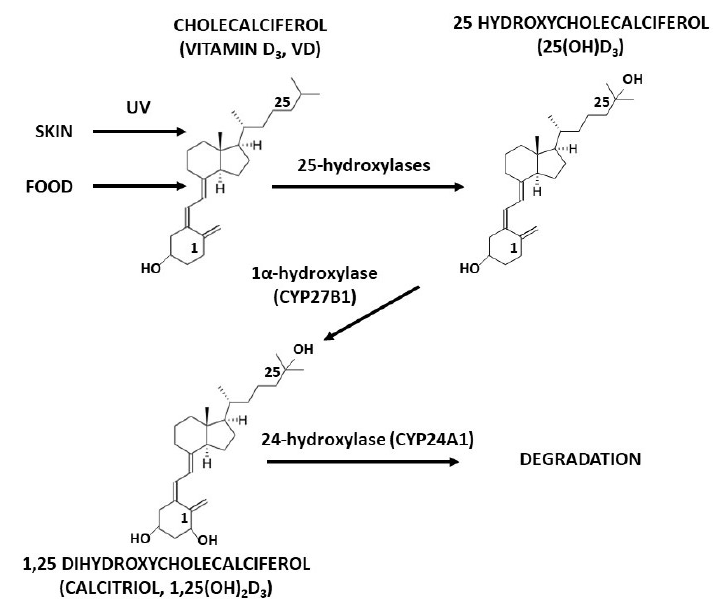
Figure 1. A simplified scheme of vitamin D metabolism. Cholecalciferol (formed under the influence of ultraviolet (UV) rays in the skin or supplied by the diet) undergoes hydroxylation at position 25 in the liver, and then in the reaction catalysed by 1 α -hydroxylase (CYP27B1), the active metabolite—1,25-dihydroxycholecalciferol (calcitriol) is formed. Hydroxylation at position 24 (catalysed by vitamin D 24-hydroxylase—CYP24A1) initiates the degradation of vitamin D metabolites.